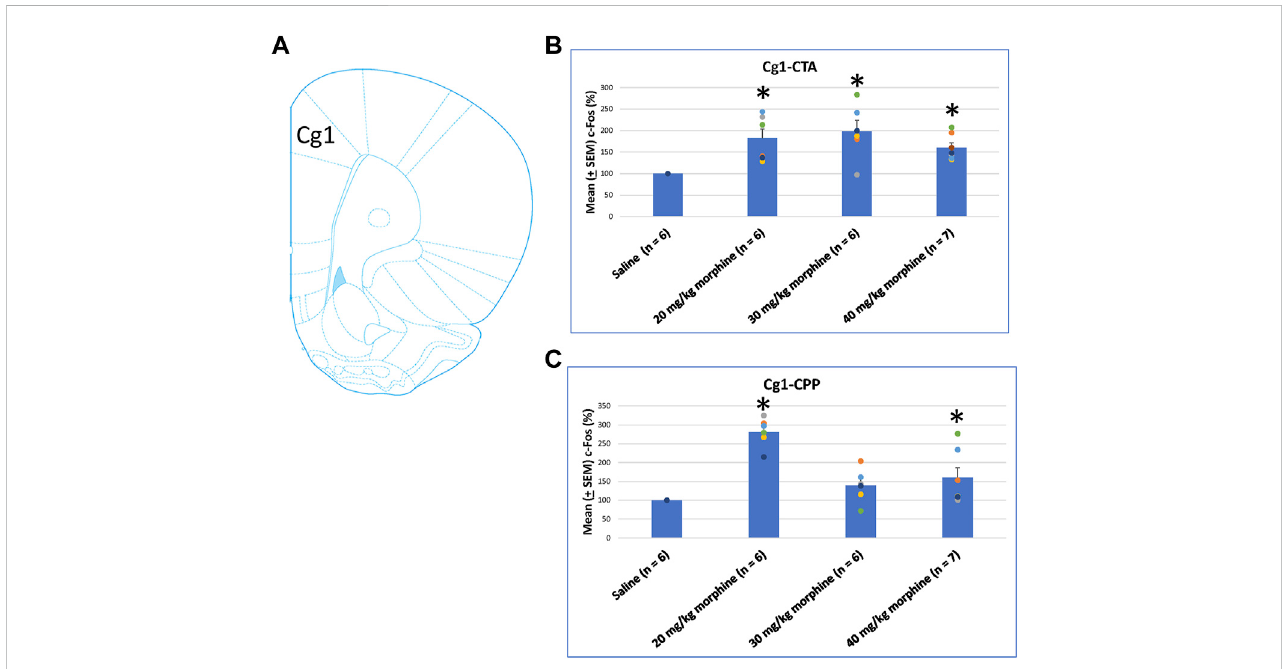
FIGURE 6 (A) Representative image ofc-Fos immunoreactivity in cingulatedcortex area 1 (Cg1). Mean (±SEM) c-Fos (%)in Cg1 following (B) CTAand (C) CPP tests. * p < 0.05 when comparing the saline for CTA and CPP (both, n = 6) or with morphine in doses of 20 mg/kg for CTA and CPP (both, n = 6), 30 mg/kg for CTA and CPP (both, n = 6), and 40 mg/kg for CTA ( n = 6) and CPP ( n =